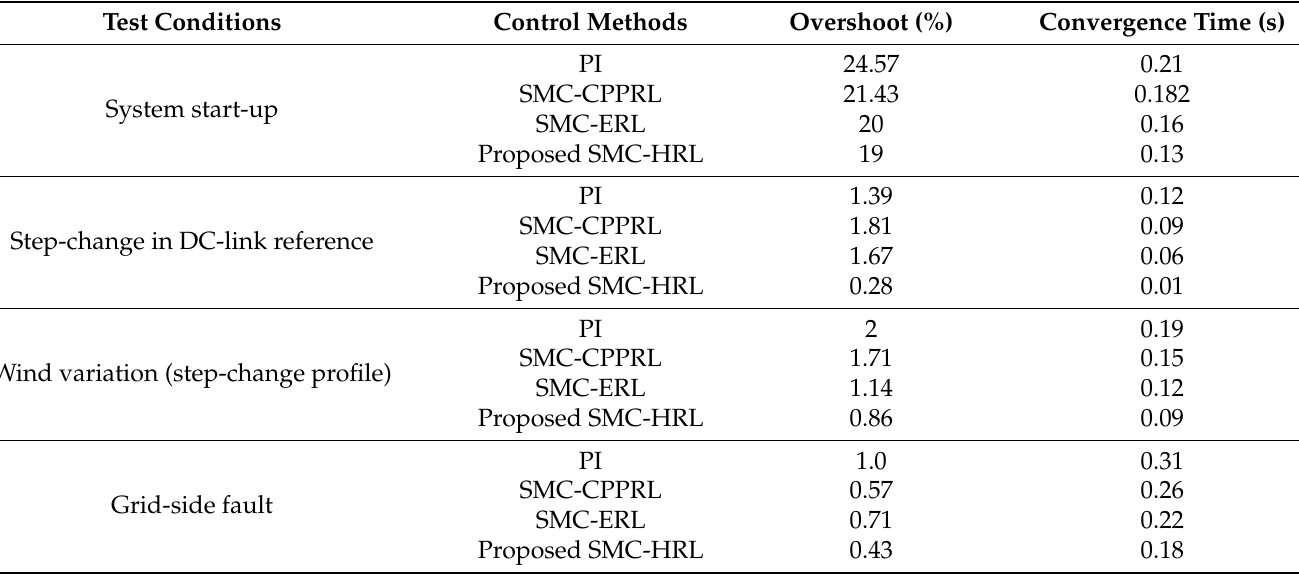
Table 2. Comparison analysis of DC-link voltage performance of four control methods from the simulation results.